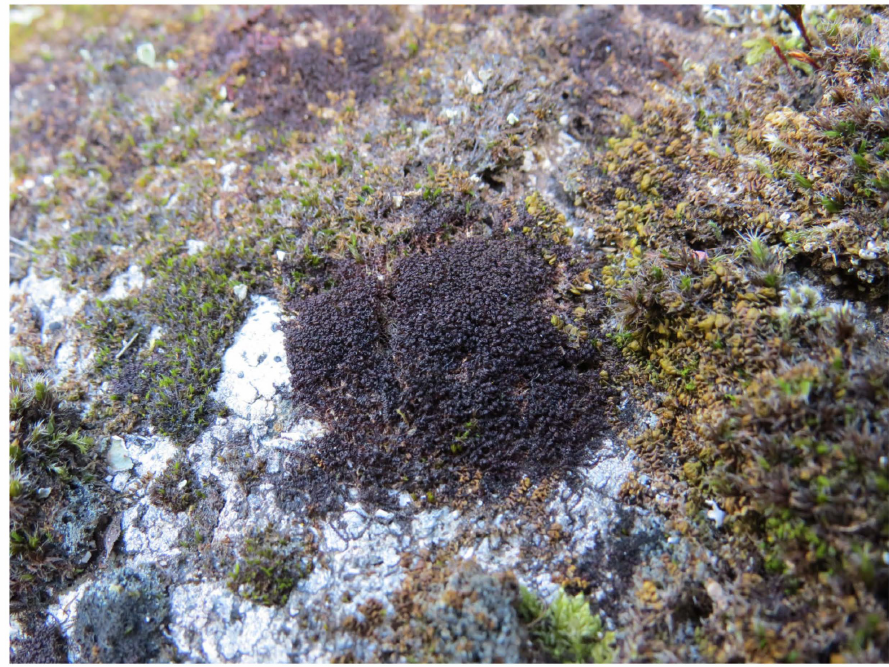
Figure 5. Dry habit of Marsupella lusitanica (paratype 1), showing the characteristic purplish black color, with Scapania compacta , Racomitrium heterostichum and Grimmia trichophylla . Photo by R.D. Porley, 1 March